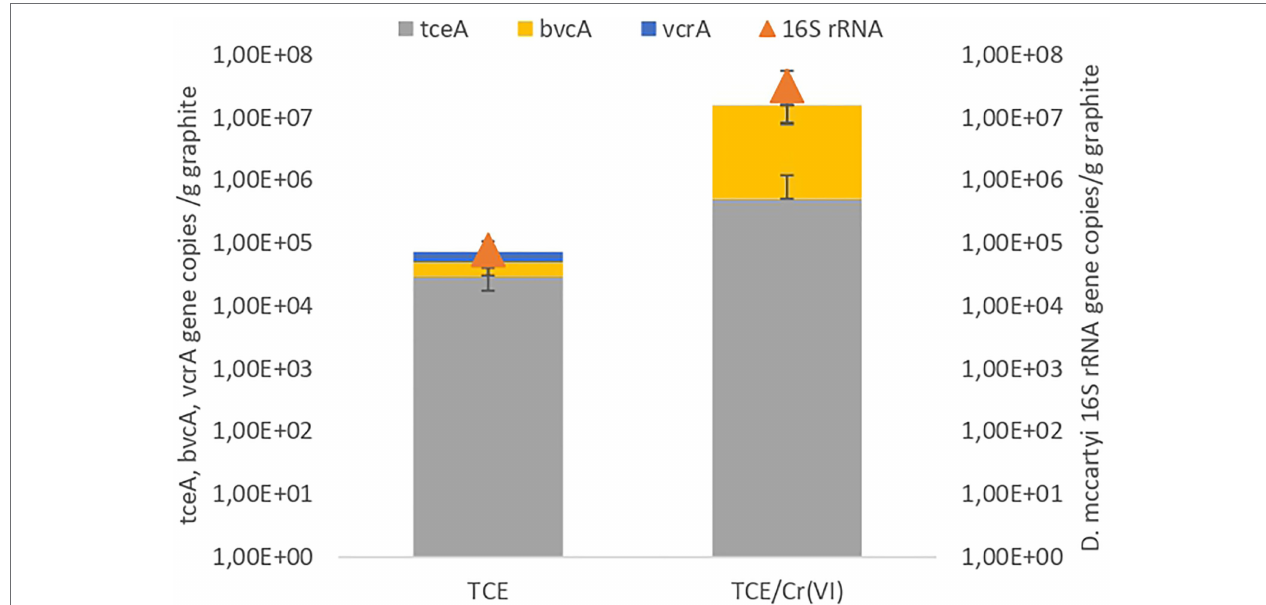
FIGURE 4 | Quantification of 16S rRNA of Dehalococcoides mccartyi and strain-specific RDase genes conducted on the samples from the operating conditions with TCE and TCE/Cr(VI). Data are plotted in log scale (base